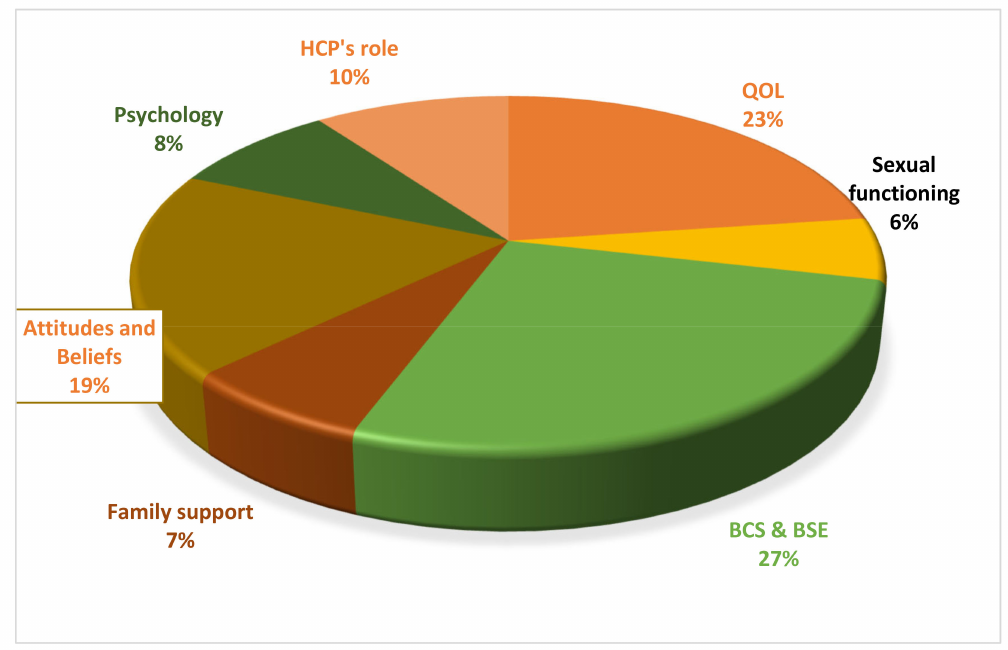
Figure 2. Topics of discussion in studies on breast